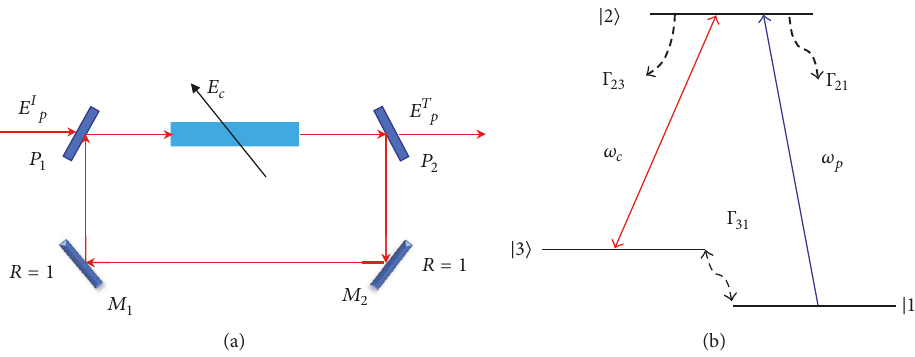
Figure 1: Schematic setup of a unidirectional ring cavity (a) containing a three-level atomic sample (b), where 𝐸 𝐼 𝑝 and 𝐸 𝑇 𝑝 denote the incident and transmitted probe field, respectively, and 𝐸 𝑐 represents the coupling field that is not circulated inside the cavity.